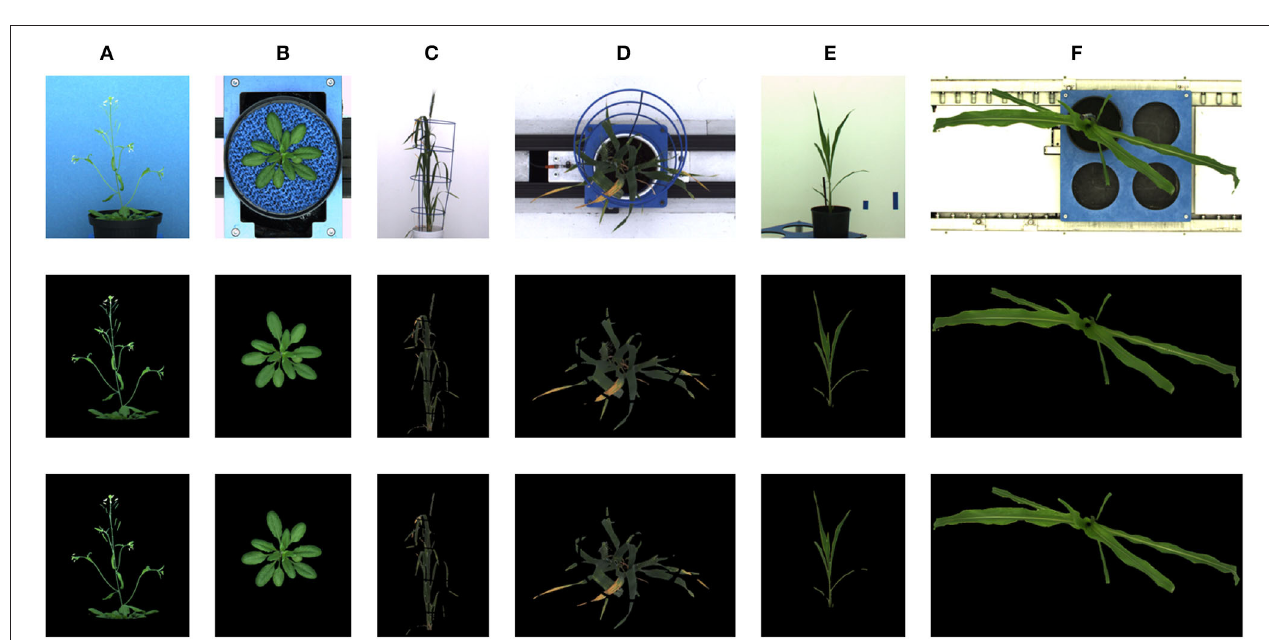
FIGURE 5 | Segmentation performance: first, second and third row represents the original RGB image, ground truth segmentation by the kmSeg tool and predicted segmentation by the DeepShoot tool, respectively. The DC of each image as following: (A) Arabidopsis side view: 0.9117, (B) Arabidopsis top view: 0.9876, (C) Barley side view: 0.9384, (D) Barley top view: 0.9617, (E) Maize side view: 0.9709, (F) Maize top view: 0.9843.